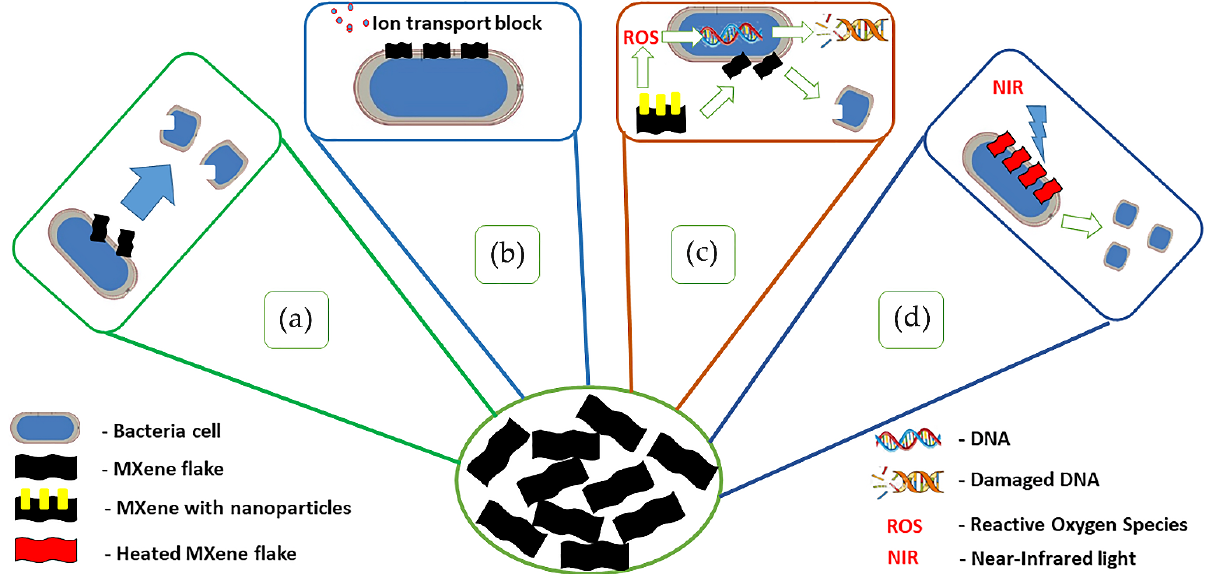
Figure 27. The scheme of proposed mechanisms of MXene antibacterial activity. ( a )—a direct invasion of sharp MXene to bacteria wall with cell membrane disintegration; ( b )—formation of the conductive bridge over the insulating lipid bilayer and ion transport block; ( c )—MXene-AuNCs provide direct MXene invasion to bacteria cells with formation of ROS by AuNCs and DNA damage; ( d )—photo-thermal ablation of bacteria after NIR light irradiation of MXenes.